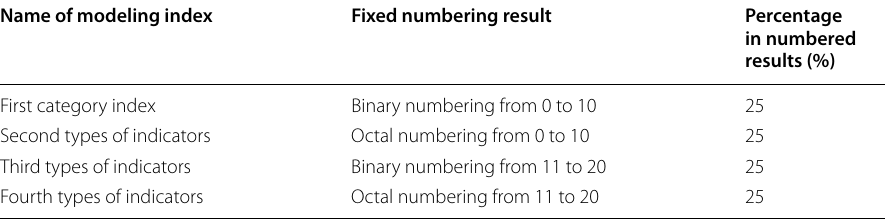
Table 1 Fixed number processing results of solid mechanics modeling